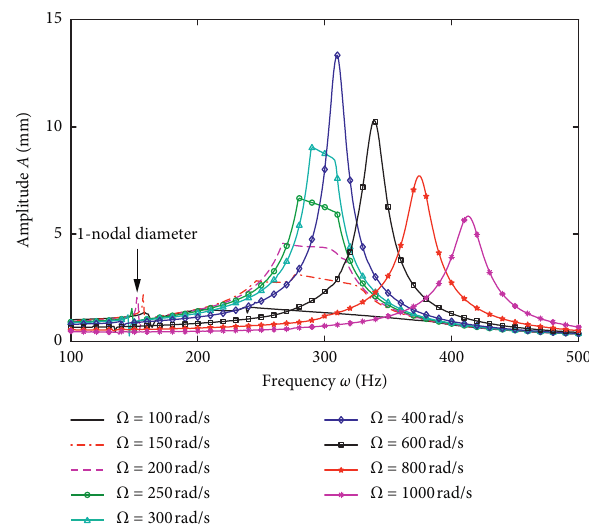
Figure 5: The amplitude-frequency response curves of beam 1 for different rotational